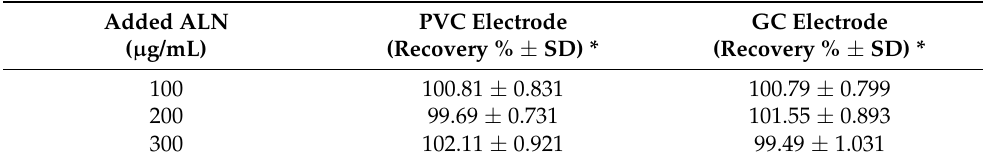
Table 7. Application of standard addition procedure for ALN determination.